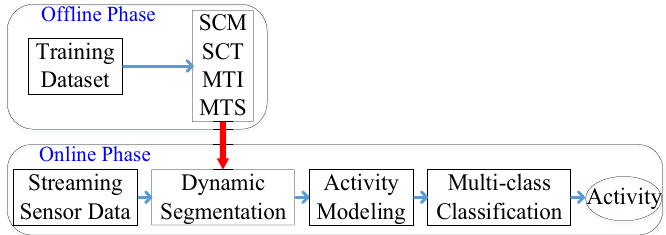
Figure 1. The flow diagram of the online AR